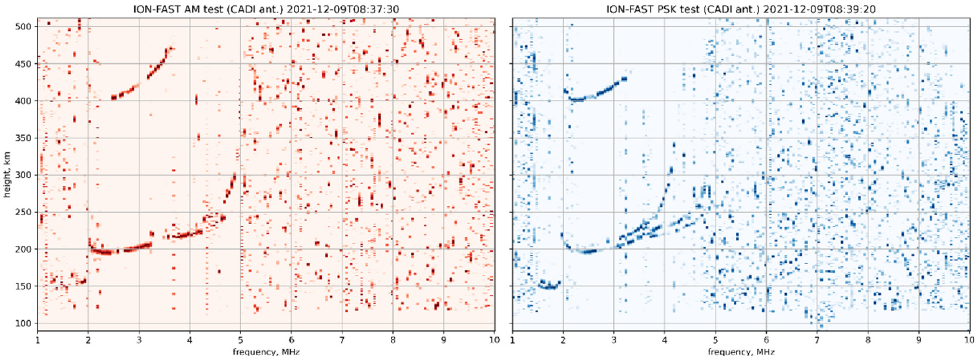
Figure 8. Examples of ionograms recorded using the developed prototype ionosonde using CADI ionosonde antennas. ( Left panel ): Barker code amplitude manipulation. ( Right panel ): Barker code phase shift